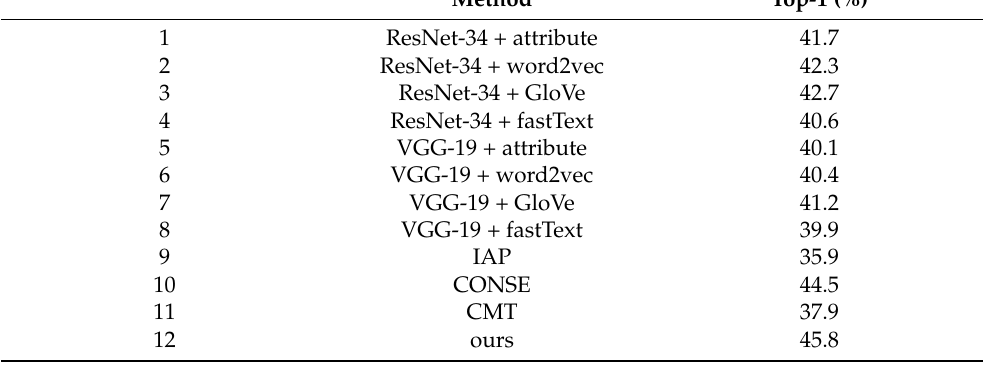
Table 5. Image classification results of different methods.